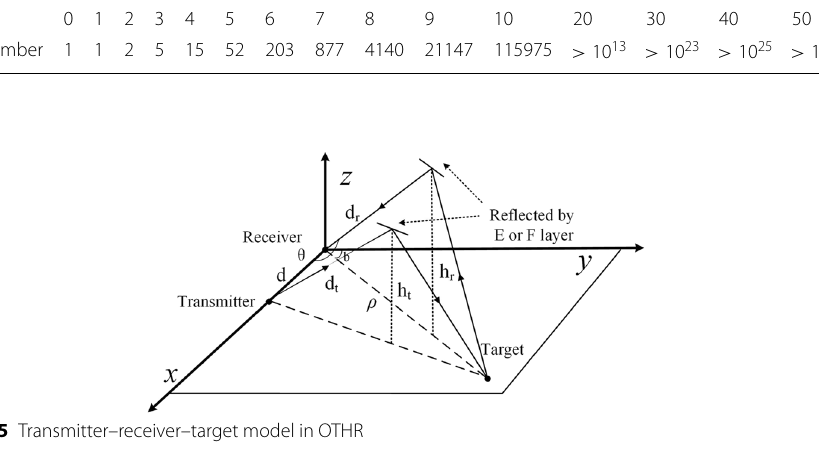
Table 4 The partitions number of the measurement set | Z |